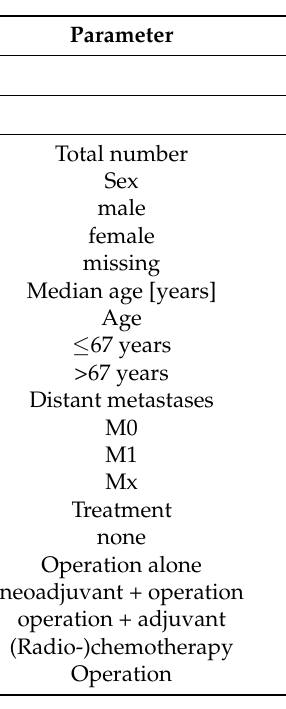
Table 1. Univariable analysis PACC versus